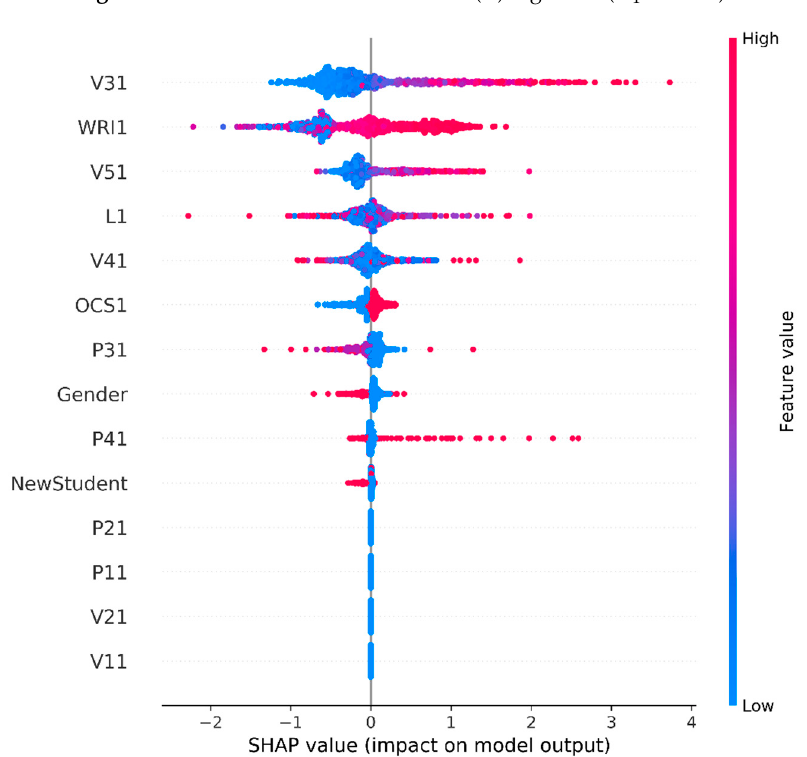
Figure 7. TreeSHAP values of the GB (ls) regressor ( D 1 dataset).